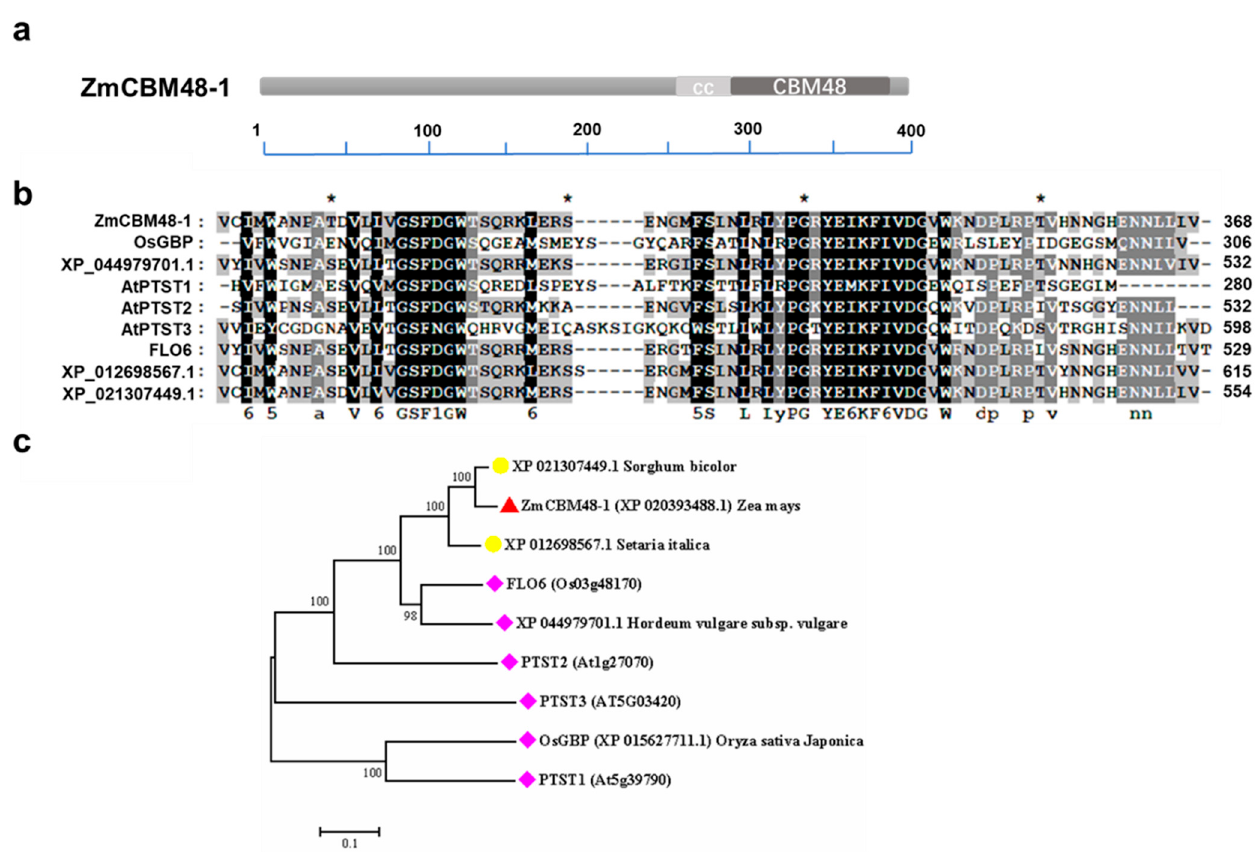
Figure 1. ZmCBM48-1 is a CBM48 domain-containing protein. ( a ) ZmCBM48-1 contains a CBM48 domain and coiled-coil (CC) domain. ( b ) Multiple sequence alignment of CBM48-containing sequences. The conserved residues of the CBM48 domain are marked with a star. ( c ) A phylogenetic tree was constructed using MEGA4.0 based on the N-J method. Bootstrap values from 1000 replicates are indicated at each node.